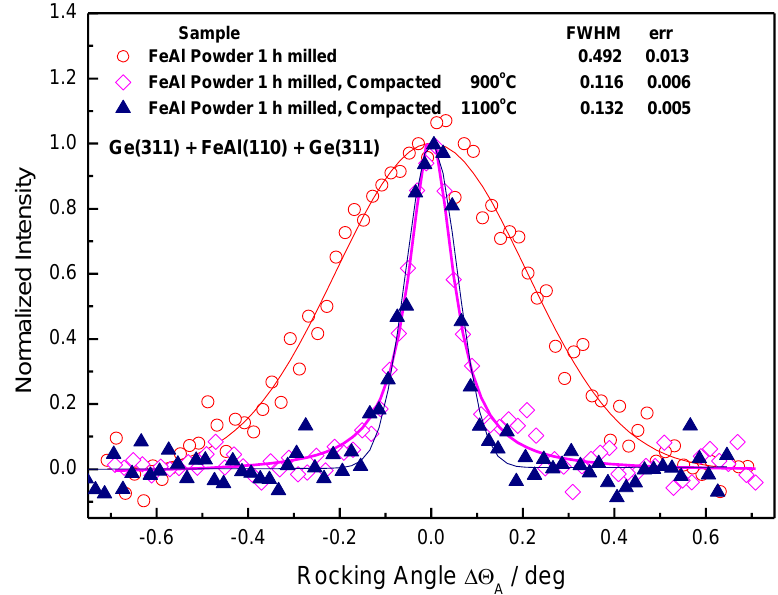
Figure 13. Analyzer rocking curves for the SPS compacted Fe28Al from 1-h milled powder sintered at 900 °C, 1000 °C, and 1100 °C.